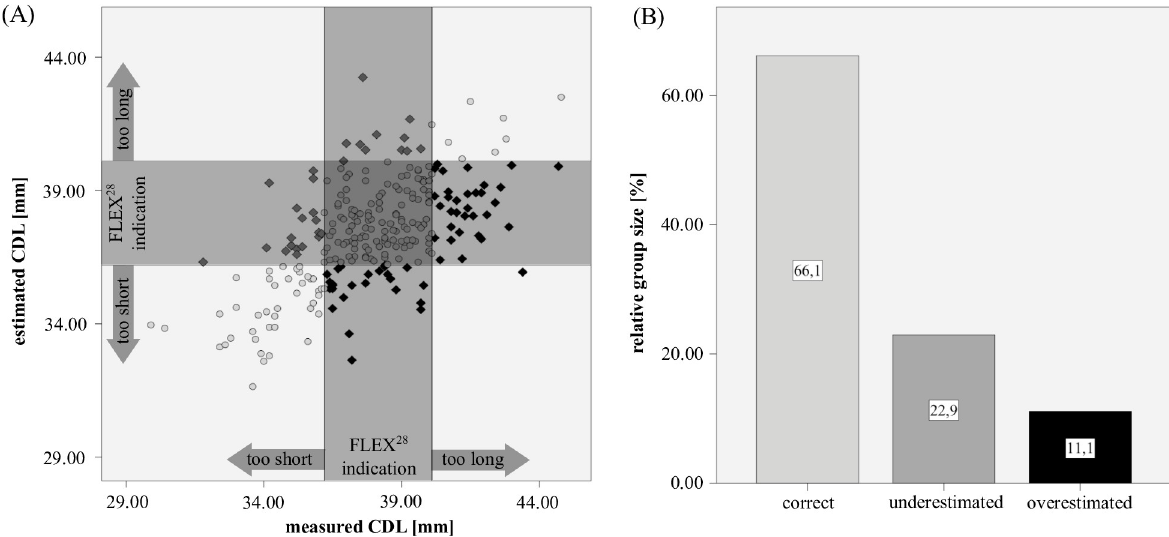
Fig 10. CDL identification of FLEX 28 candidates. (A) the comparison of measurement and estimation-based identifications of FLEX 28 candidates resulted in (B) correct identifications in 66% of the analyzed anatomies using Escude´’s method.